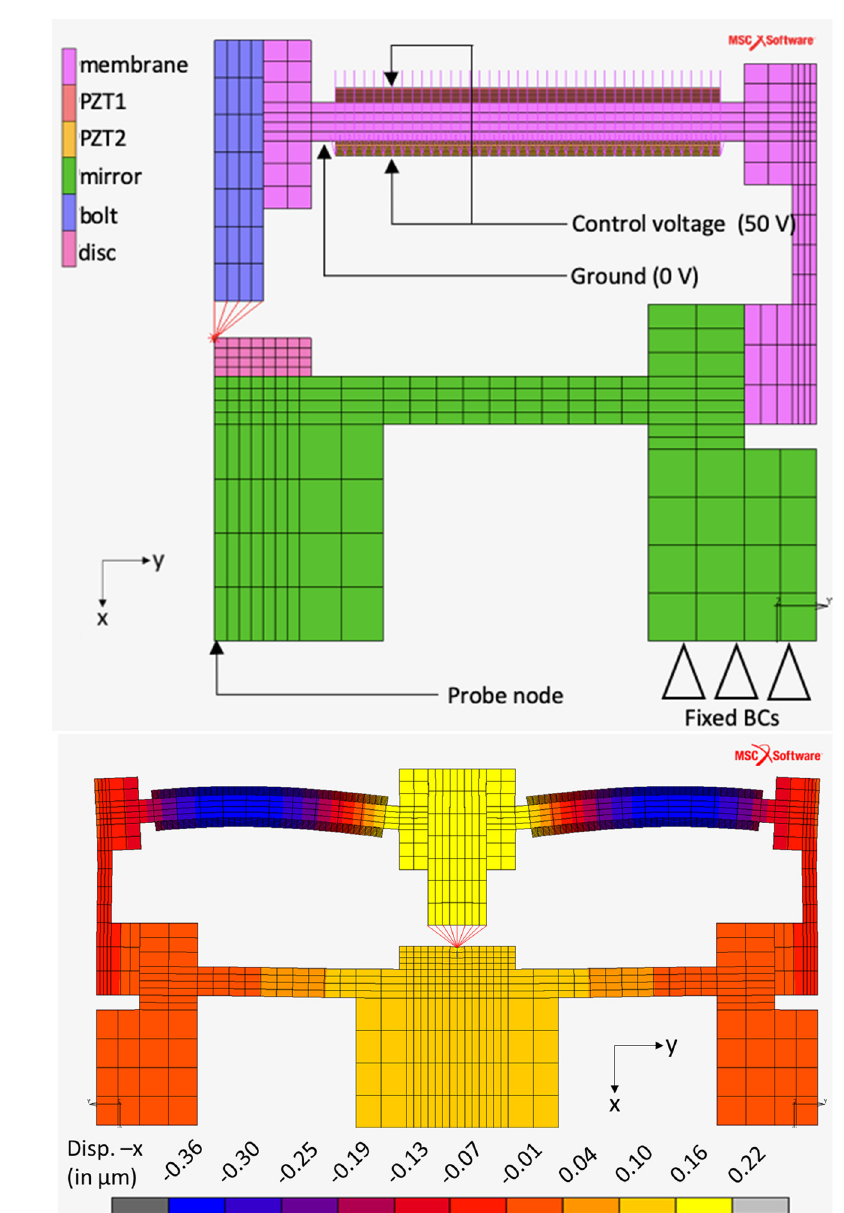
Figure 6. Finite element analysis for the PLC. ( a ) Model definition; ( b ) vertical displacement results.